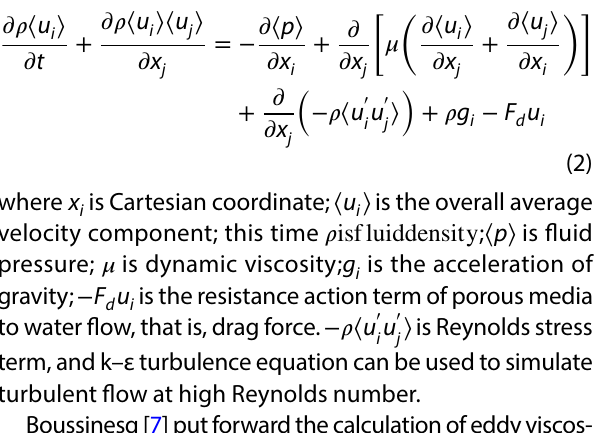
Fig. 2 Schematic diagram of numerical calculation of long-span particles on the rocky